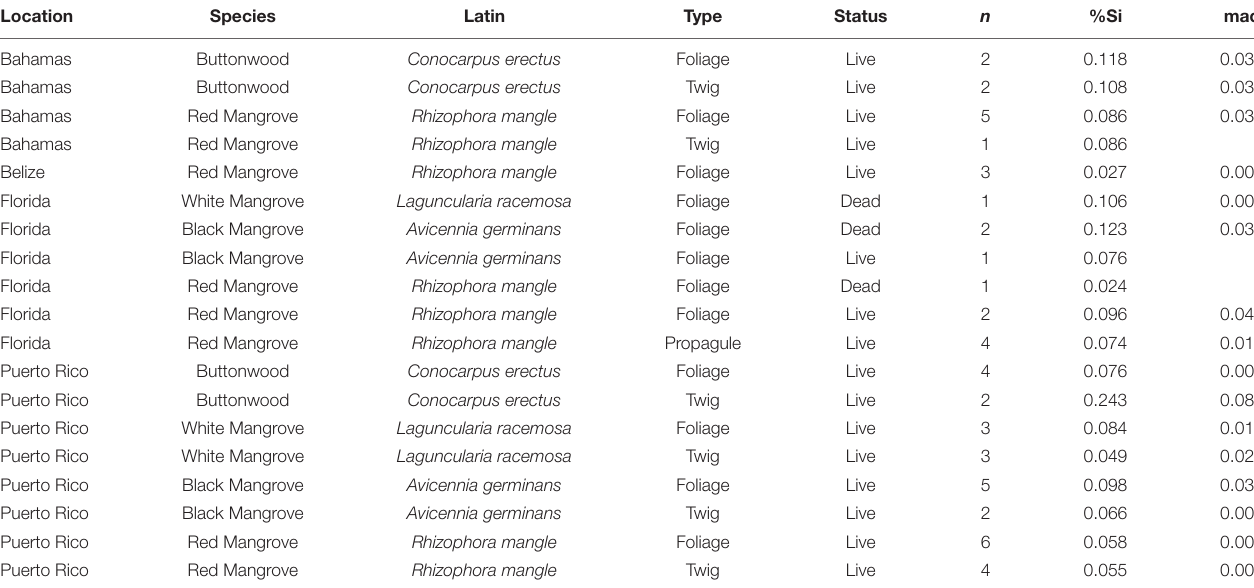
TABLE 1 | Median, median absolute deviation (mad), sample type, status, and the number of trees sampled ( n ) for mangrove Si concentrations (as %Si by dry weight) organized by location and species.